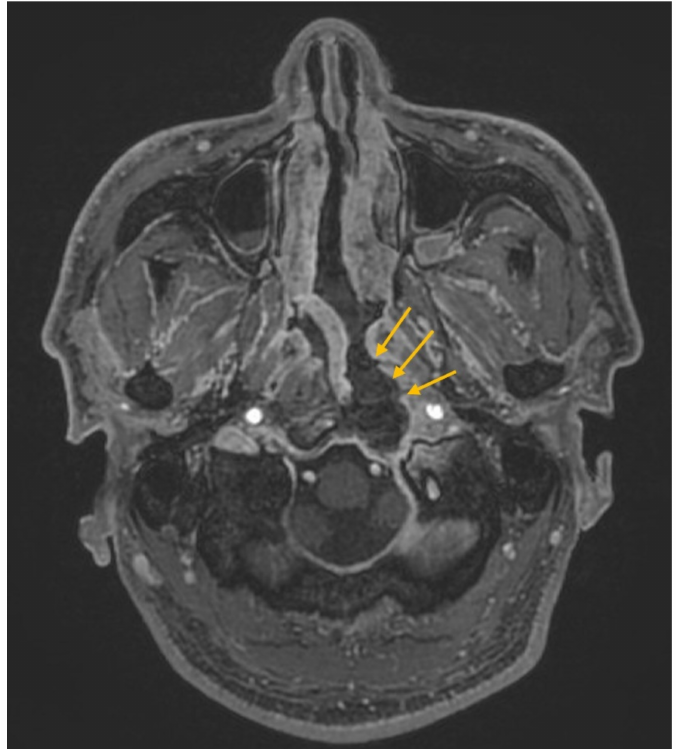
Figure 5. Post-operative follow-up MRI only demonstrated post-operative changes (arrows) and did not reveal any evidence of IPT